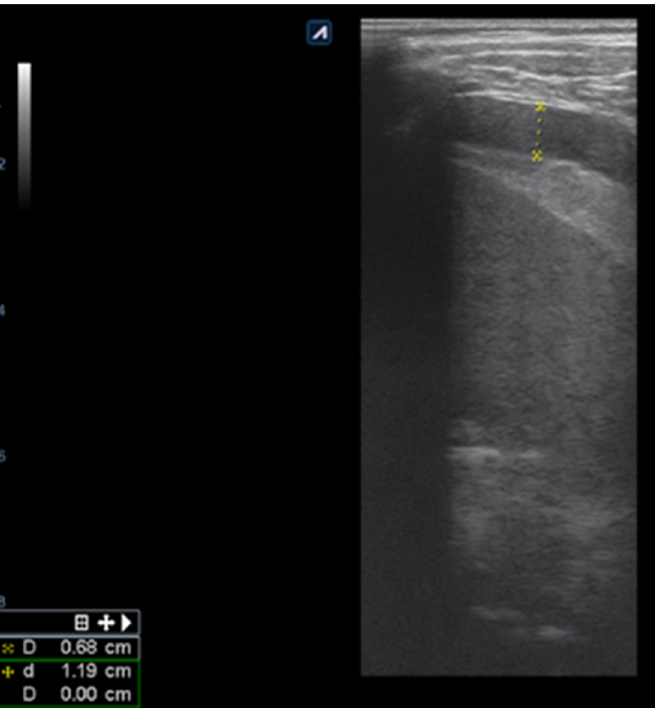
Figure 6. Pleural effusion (marked with X); interpleural distance of 0.68 cm, approximately 136 mL (distance ×20 = 136 mL).